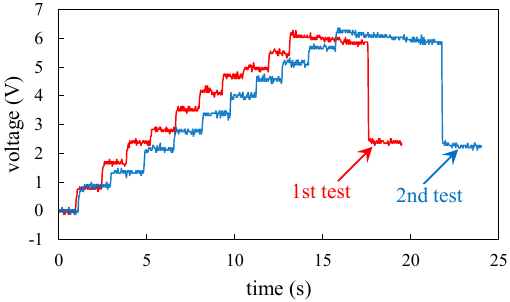
Figure 13. The measured voltage of the capacitor in the lighting up LED experiment.